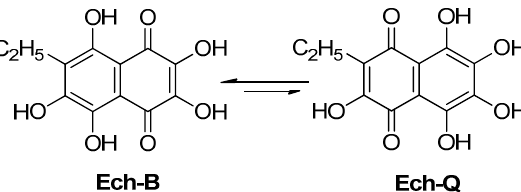
Figure 9. Tautomeric forms of Ech A: Ech-B (ethyl in the benzene ring) and Ech-Q (ethyl in the quinonoid ring).